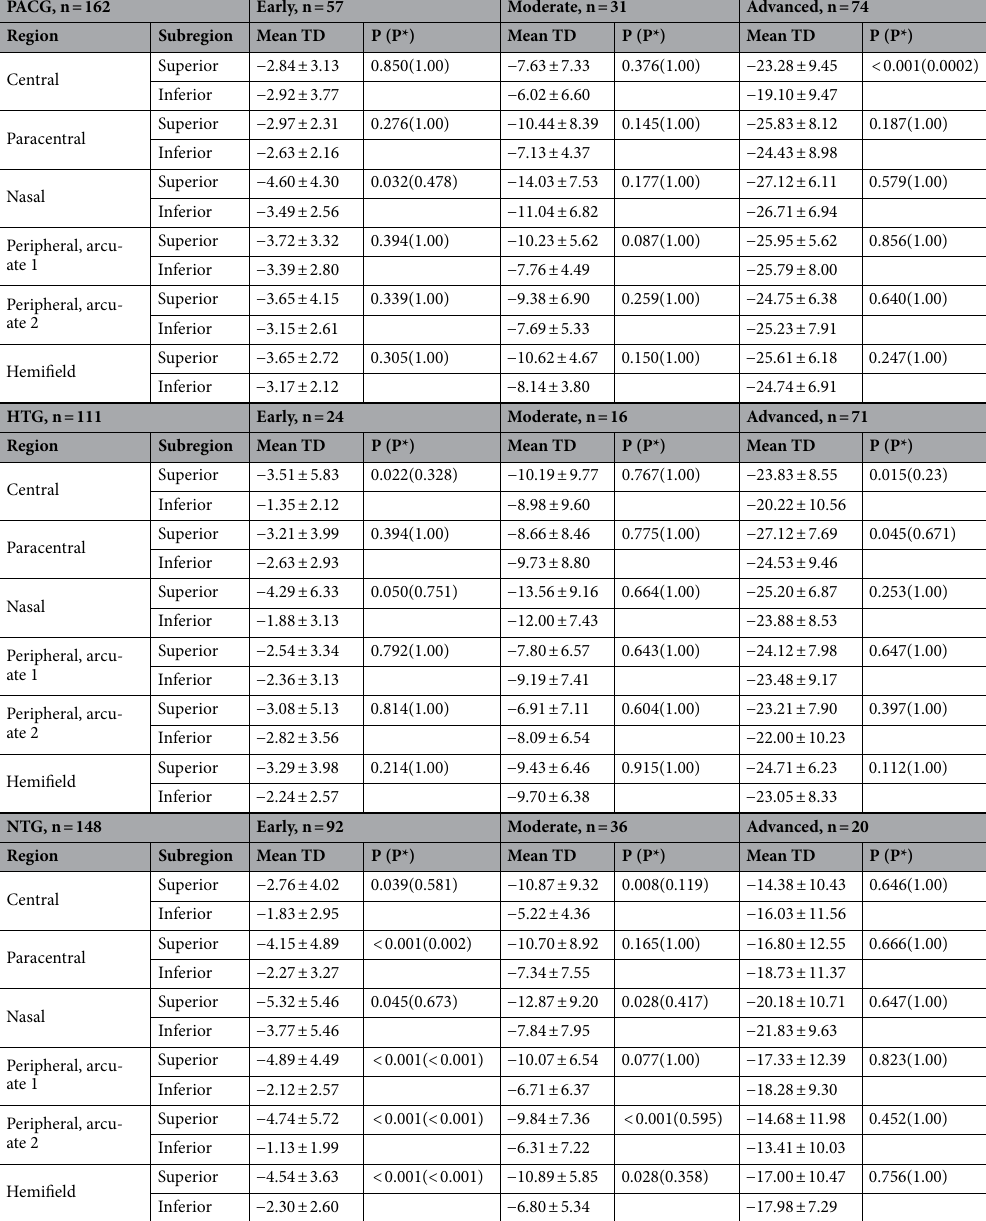
Table 3. Glaucoma hemifield test region pattern deviation for participants. TD total deviation. * P values after Bonferoni correction. Data are mean ± standard deviation unless otherwise